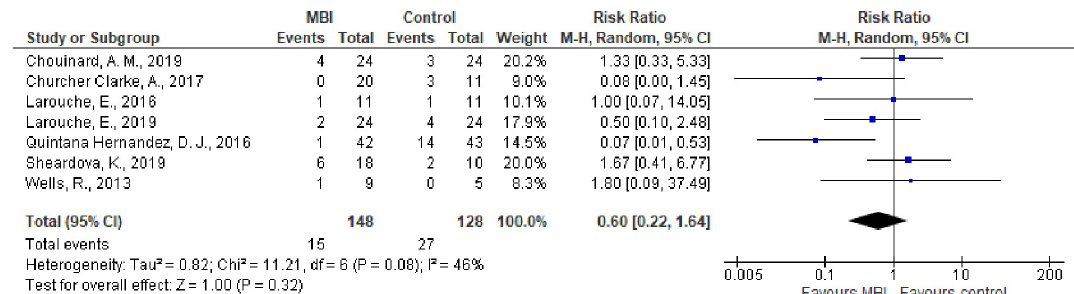
Fig 2. Forest plot of comparison: Attrition, MBI versus